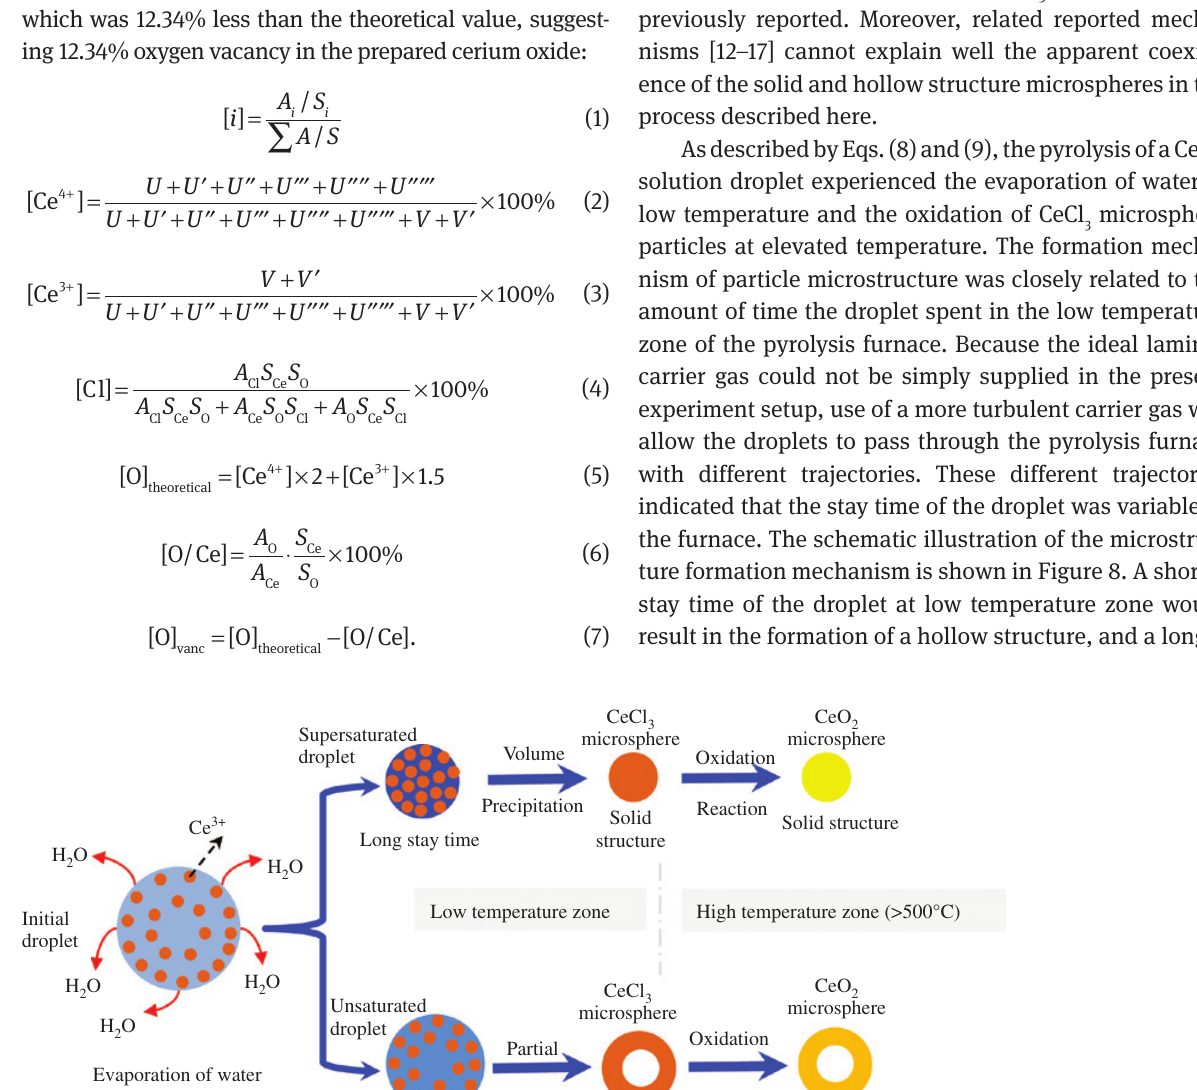
Figure 8: Schematic of the microstructure formation mechanism of CeO tion in air